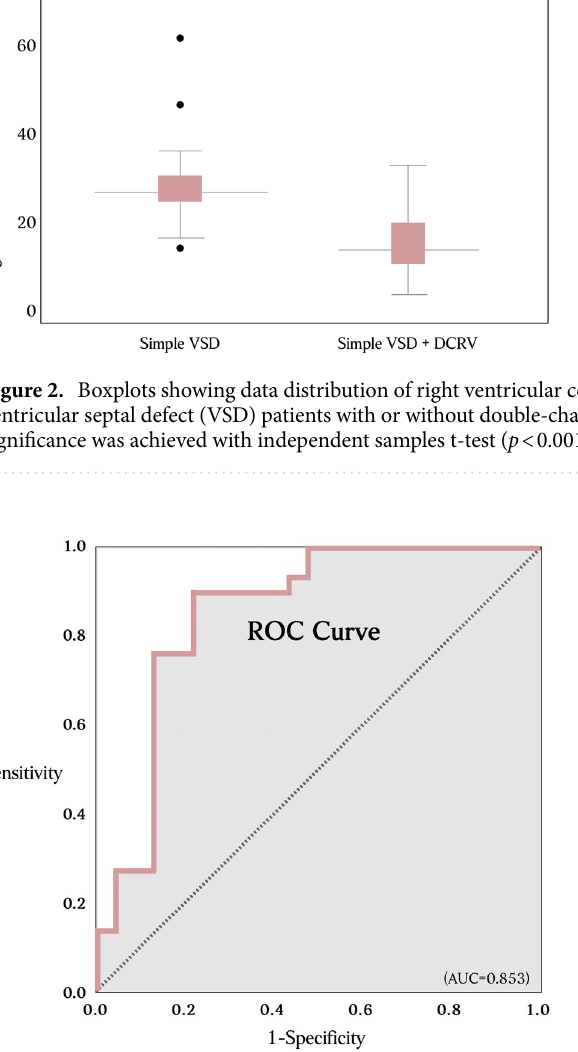
Figure 3. The high area under curve (AUC = 0.853) indicates good reliability of right ventricular constrictive ratio in double-chambered right ventricle prediction, with an optimal cutoff value of 20.1%. [ ROC receiver operating